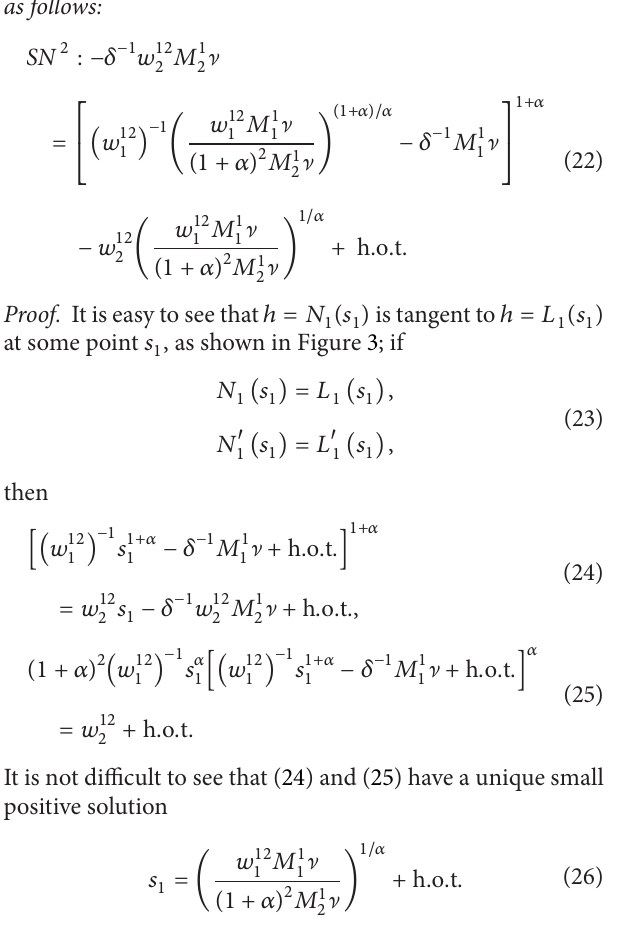
Figure 2. That is, system (1) has a unique large 1-periodic